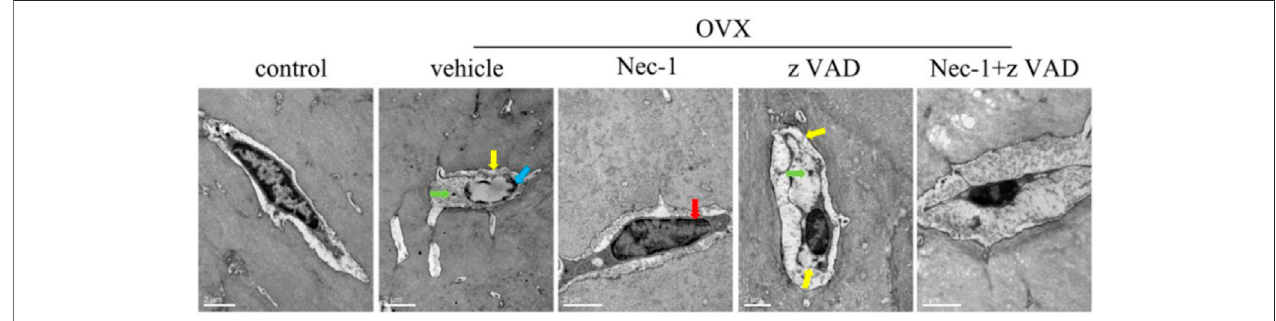
FIGURE3| Deadosteocytes wereseenbyTEM.(A)TEMimagesofosteocytesinsham-operatedratsandOVX ratstreatedwithvehicle,Nec-1, zVAD,or Nec-1+ zVAD(scalebar (cid:1) 2 μ m).Redarrow:condensednucleus,bluearrow:chromatinclumping,greenarrow:swellingorganelle,yellowarrow:membranerupture.## p < 0.01 compared with the control group, * p < 0.05 compared with the vehicle group, ** p < 0.01 compared with the vehicle group.